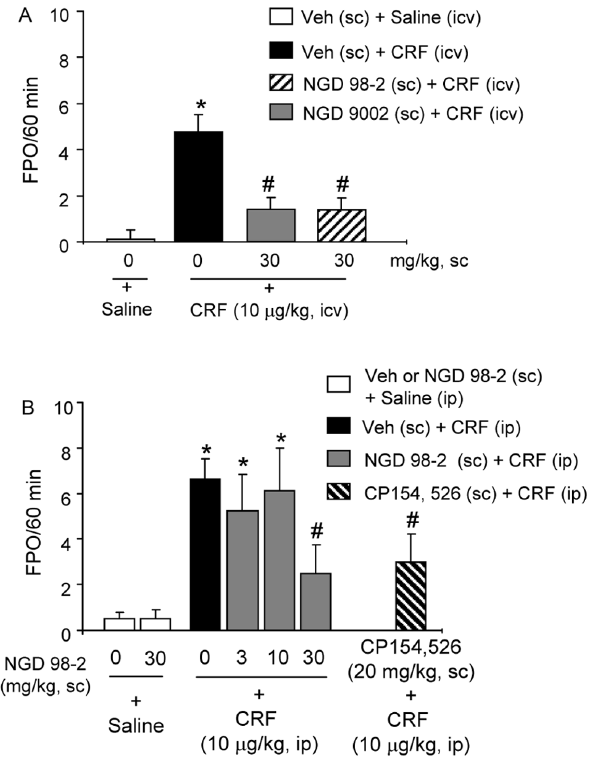
Figure 2. Subcutaneous injection of CRF 1 antagonists, NGD 9002 or NGD 98-2 prevents central (icv) or systemic (ip) CRF- induced stimulation of propulsive colonic motor function in conscious rats. A: Rats with chronic icv cannula were pretreated sc with vehicle, NGD 98-2 or NGD 9002 and 60 min later were injected icv with saline or CRF and FPO monitored for 60 min. B: Rats were pretreated sc with either vehicle or NGD 98-2 (3, 10, 30 mg/kg) and 60 min later, they were injected ip with CRF or saline. As a positive control, a group of rats was injected sc with a known CRF 1 antagonist, CP154,526, 60 min prior to ip CRF and FPO monitored for 60 min. Each bar represents the mean and SEM of 8 rats/group. *p , 0.05 compared with sc vehicle + icv saline group (A) or vs sc vehicle + ip saline group (B); # p , 0.05 compared with sc vehicle + icv CRF (A), or vs sc vehicle + ip CRF B), ANOVA,